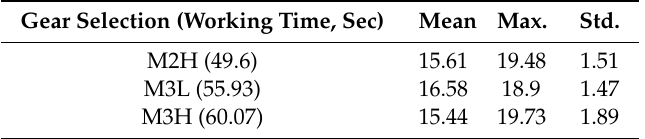
Table 4. Descriptive statistics of the measured tillage depth (cm) during plow tillage. Gear Selection (Working Time,